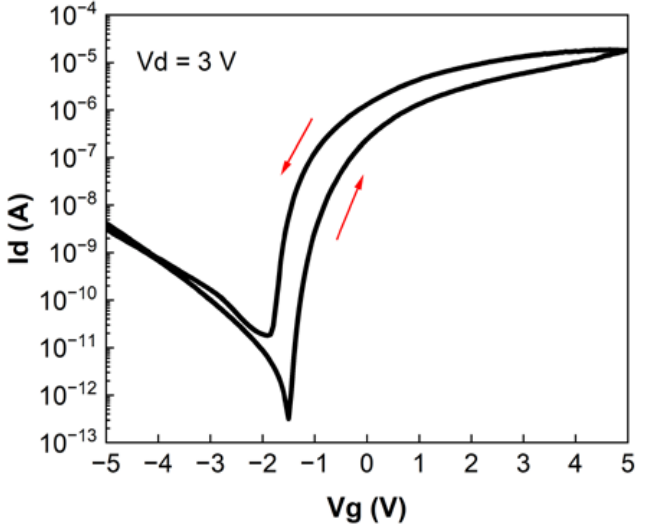
Figure 3. Transfer curve of the AlO x /InO x electric-double-layer transistor (EDLT) with planar gate.